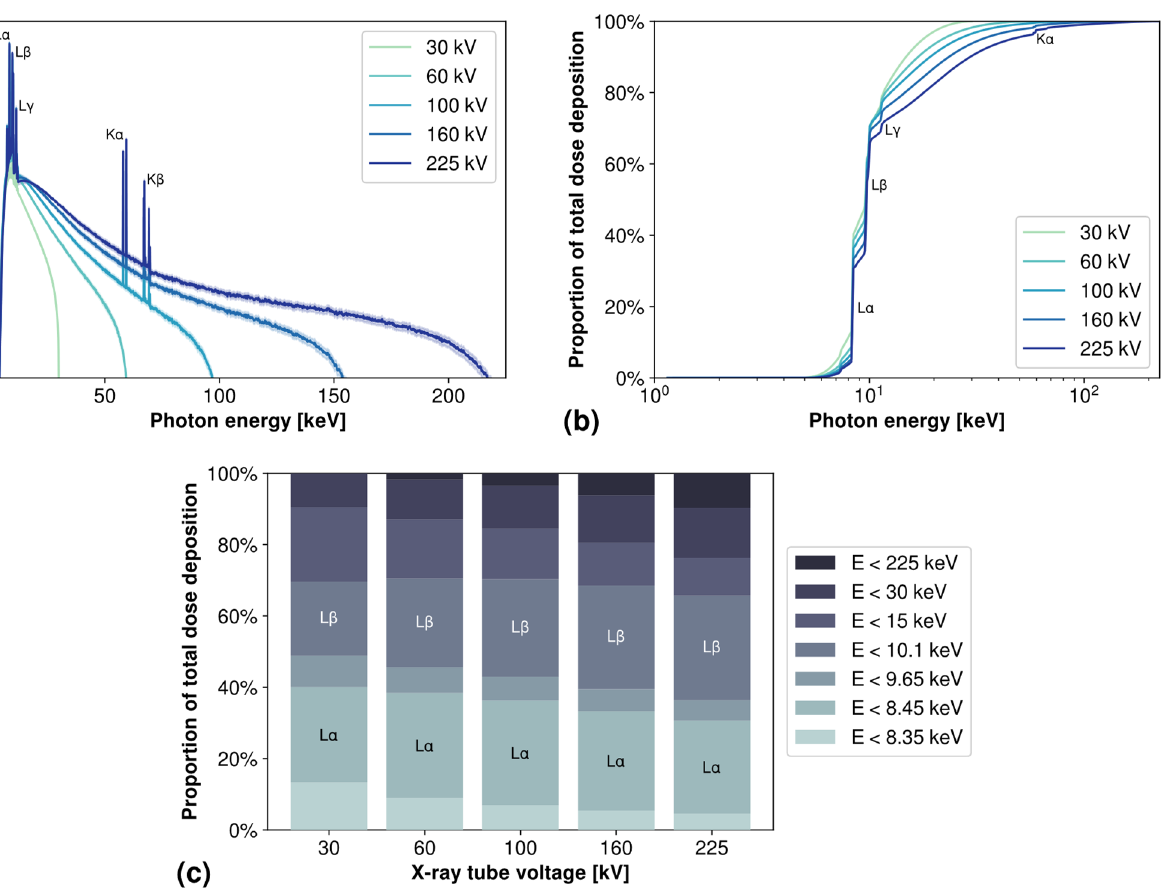
Figure 7. For five different source voltages between 30 kV and 225 kV: ( a ) Simulated dose deposition spectra of the X-ray beam inside the OF. The names of the main characteristic X-ray emission lines of tungsten are given next to the corresponding peaks. Filled areas indicate uncertainties at ± 2 σ . ( b ) Simulated cumulative dose deposition spectra of the X-ray beam, in an energy interval up to 30 keV. The name of the tungsten characteristic X-ray lines contributing the most to dose deposition are shown next to the corresponding sharp increases. ( c ) Stacked bar plot of simulated cumulative dose response showing the contribution of each energy interval to the total dose. Contributions due solely to characteristic tungsten X-ray lines L α and L β are indicated inside the corresponding bins.